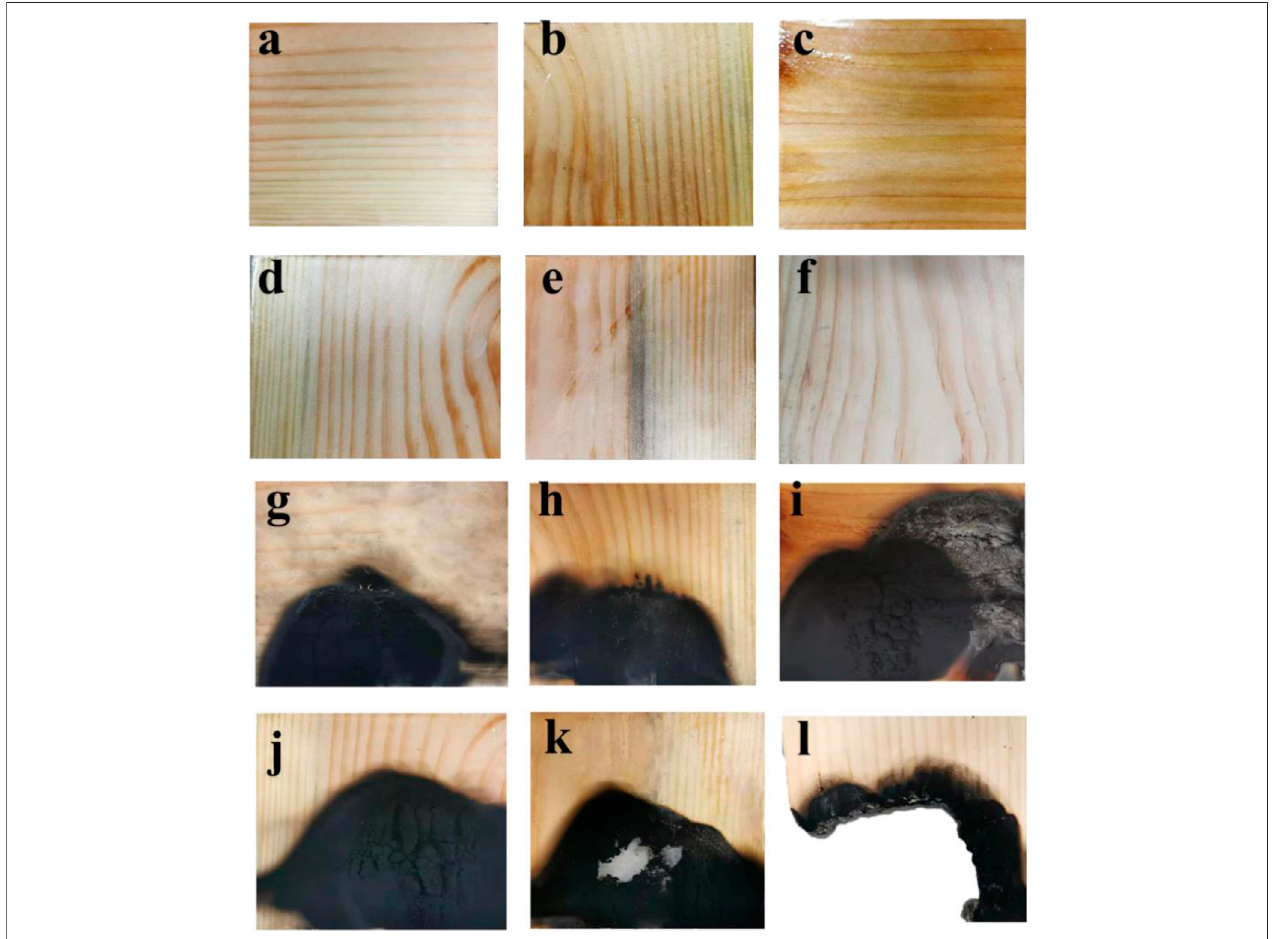
FIGURE9| Beforebacktemperaturetest (A – F) andafterbacktemperaturetest (G – L) . (A – F) ,Woodwithcoating-1,coating-2,coating-3,coating-4,coating-5and pure wood. (G – L) , Wood with coating-1,coating-2,coating-3, coating-4, coating-5 and pure wood.)